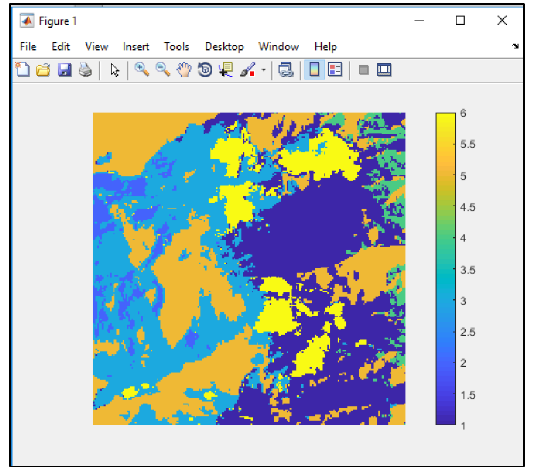
Figure 14. Example of SVM classification results derived in the classification module.